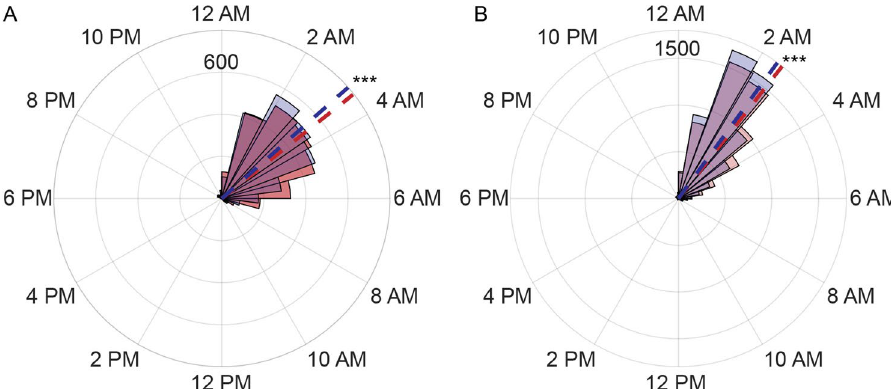
Figure 1. Sleep midpoints are significantly different in the two groups. The distribution of sleep midpoints in the morning (blue shade) group is earlier than that of the evening (red) group on free nights ( A ) and work nights ( B ). The mean sleep midpoints are plotted as dashed lines. On free nights ( A ), the mean sleep midpoint of the morning group is 3:15 AM (n = 2771 sleep events), and the mean sleep midpoint of the evening group is 3:26 AM (n = 2754 sleep events, F-statistic = 12.83, P = 3.43e−4, Parametric Watson-Williams multisample test for equal means). On work nights ( B ), the mean sleep midpoint of the morning group is 2:25 AM (n = 7296), and the mean sleep midpoint of the evening group is 2:33 AM (n = 7227 sleep events, F-statistic = 20.15, P = 7.2e−6, Parametric Watson-Williams multisample test for equal